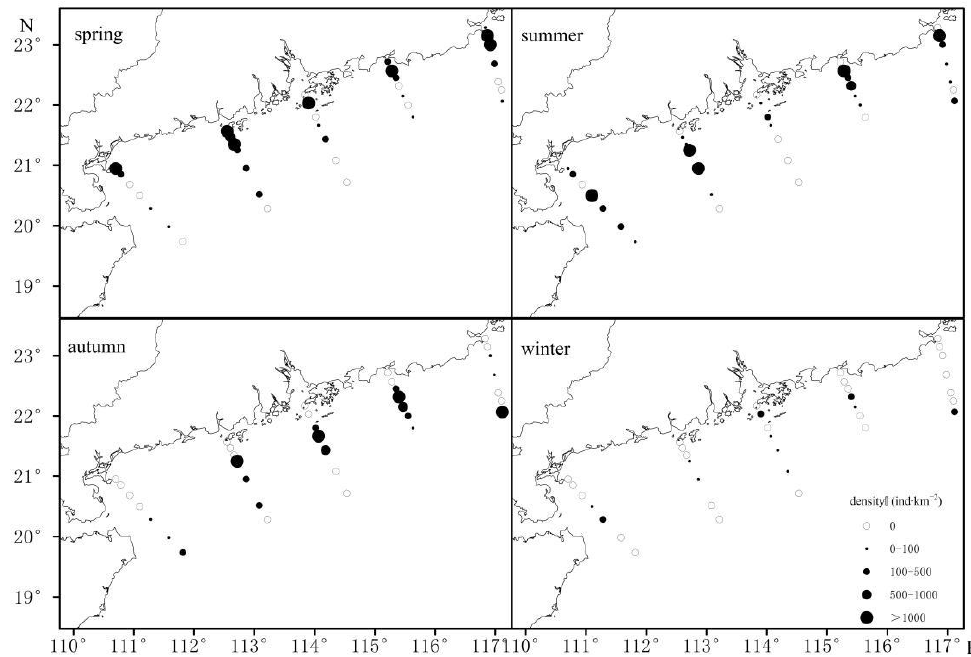
Figure 3. Temporal and spatial distribution of Evynnis cardinalis density in the northern South China sea.